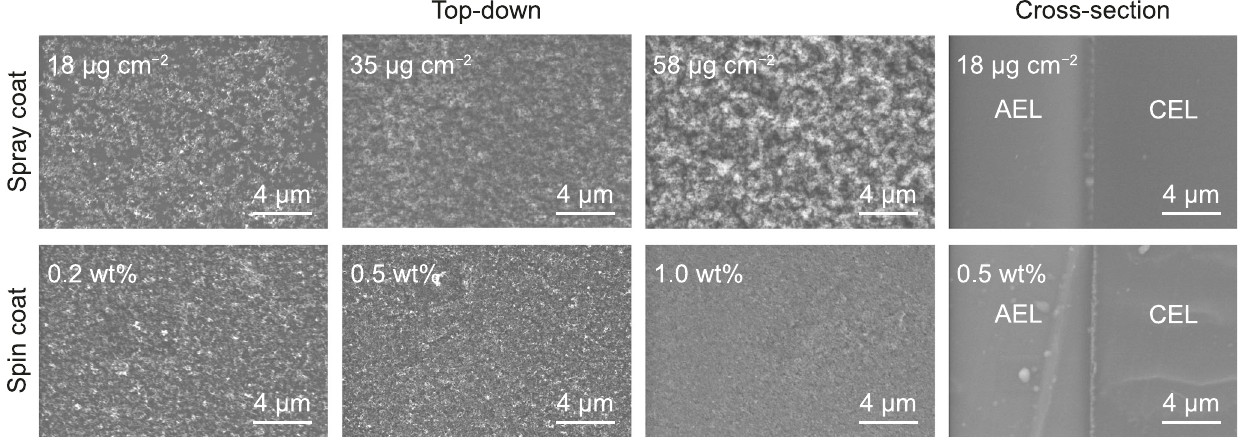
Fig. 3 SEM images of TiO2-P25 on the CEL and BPM cross-sections. For spray-coated samples, the approximate loadings are given while for spin-coated samples, the ink concentrations are given. The optimal spin-coated WD catalysts layers are smoother, with more-uniform coverage, but only marginally improved